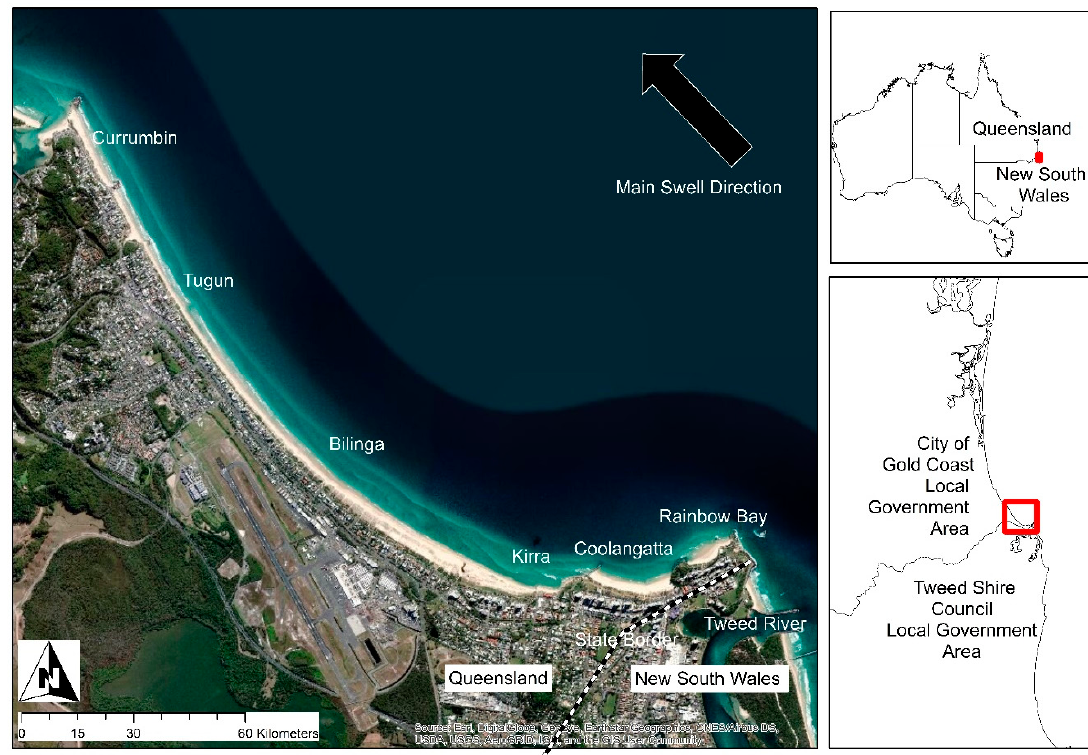
Figure 1. Map of Gold Coast showing key locations and main swell direction.